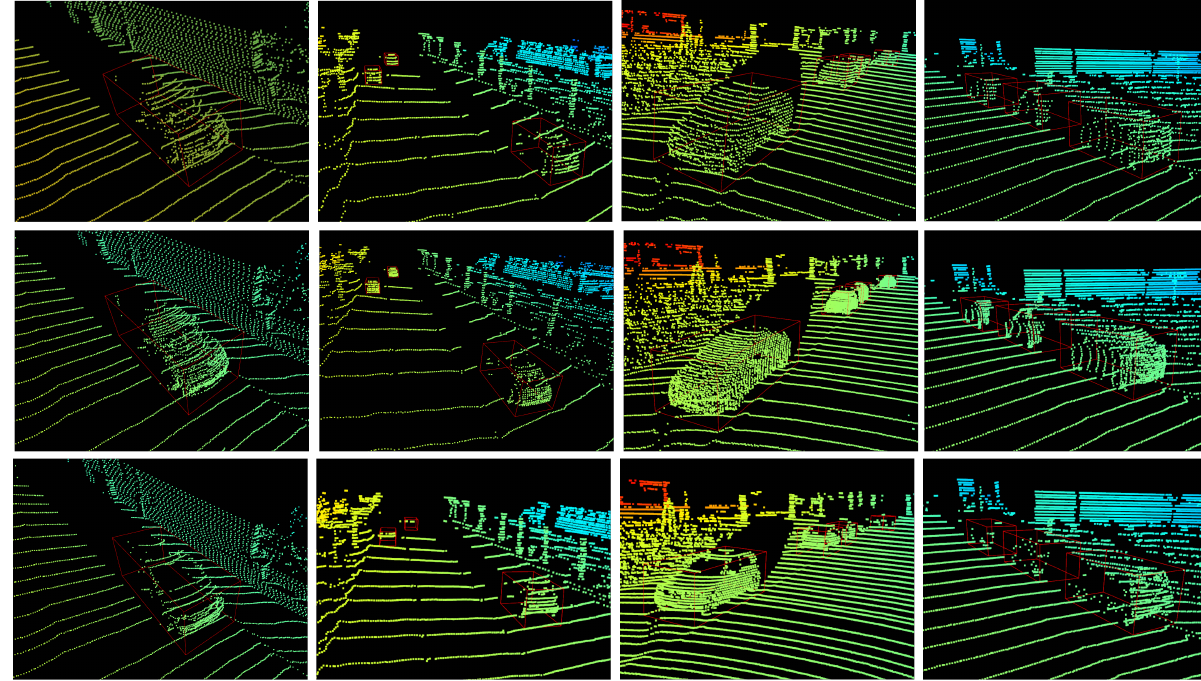
Figure 8. The visualization of ShapeKITTI (first row), MobilePointClouds (second row), and KITTI (last